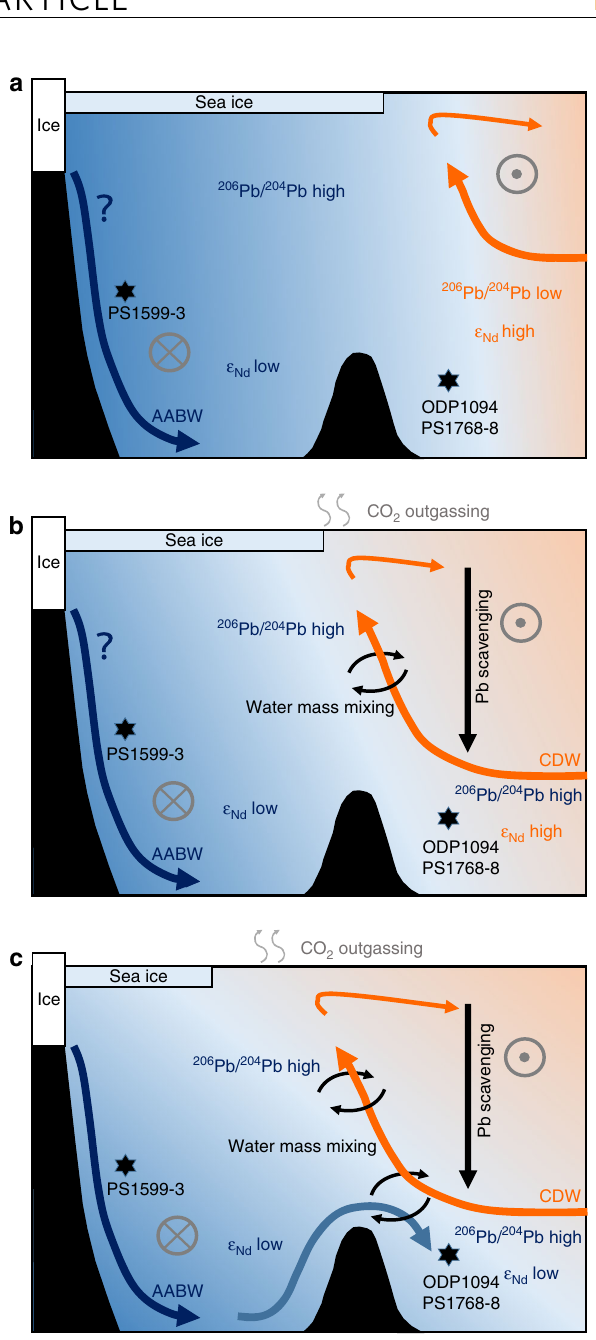
Fig. 4 Hypothesized Southern Ocean circulation modes. a LGM- overturning con fi guration with northward-shifted Southern Ocean circulation cell and absence of Weddell Sea-derived AABW at ODP Site 1094/Site PS1768-8, resulting in unradiogenic (low) 206 Pb/ 204 Pb and local radiogenic (high) ε Nd signature. b Early deglacial overturning as experienced preceding the Antarctic Cold Reversal (~15 ka). Southward displacement of Southern Ocean overturning cell, leading to entrainment of a Weddell Sea-sourced radiogenic (high) Pb isotope signal. c Post-Younger Dryas (YD) (since ~11 ka) and Holocene overturning con fi guration. Reinvigoration of AABW export resulted in the convergence of ε Nd inside and outside of the Weddell Sea. Crosses mark predominant westward fl ow directions and the point symbol denotes eastward fl ow. LGM: Last Glacial Maximum; AABW: Antarctic Bottom Water; CDW: Circumpolar Deep